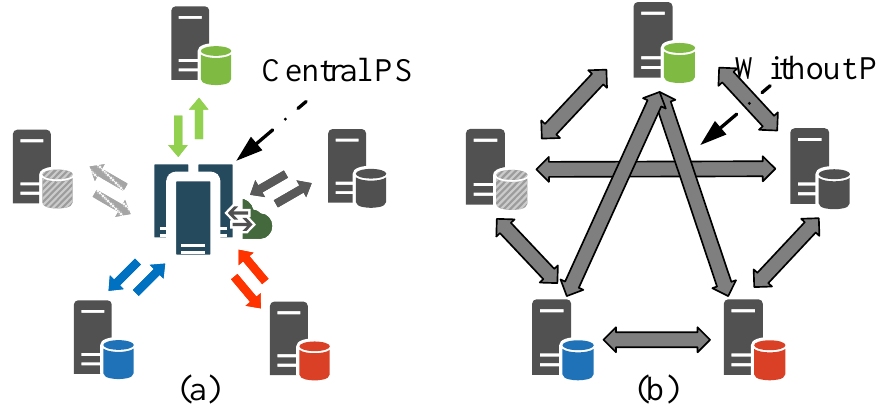
Figure 1. An overview of ( a ) centralized topology and ( b ) decentralized